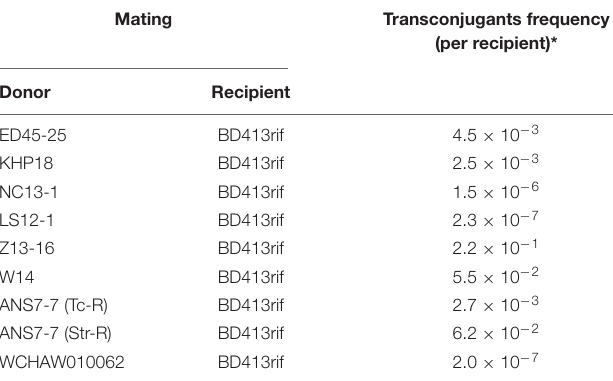
TABLE 5 | Frequency of conjugative transfer of environmental plasmids from the group III-4a.